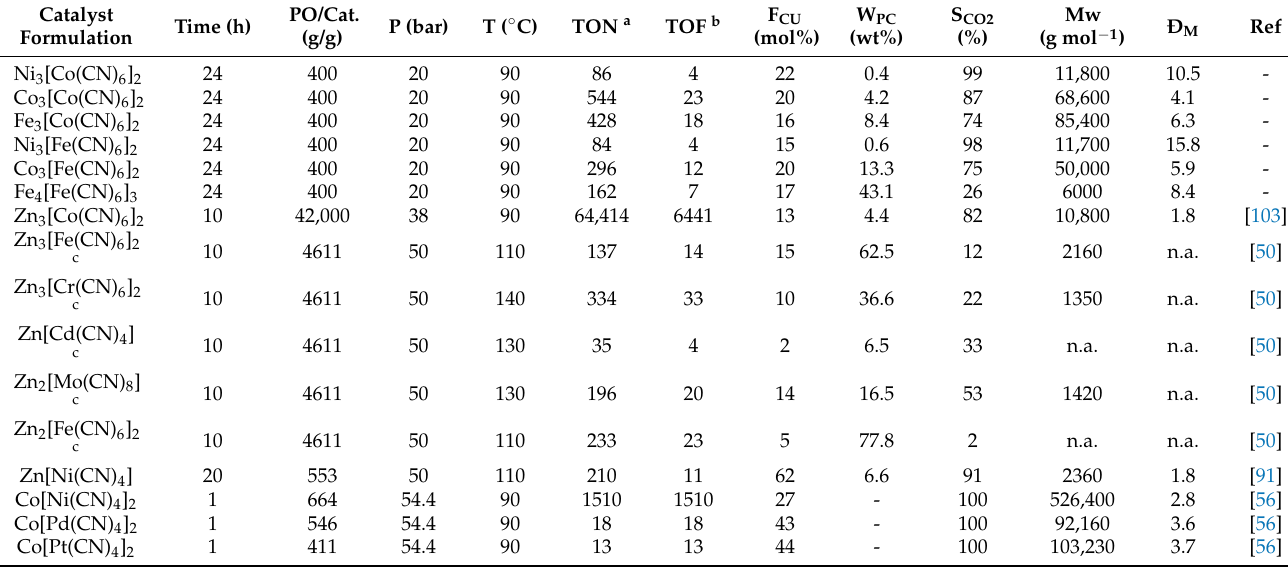
reduced the molecular weight of the final product. Table 10. Comparison of the performance of the studied porous hexacyanometallate(III) complexes with other cyanometal- late catalysts in the copolymerization of CO 2 and PO. Catalyst